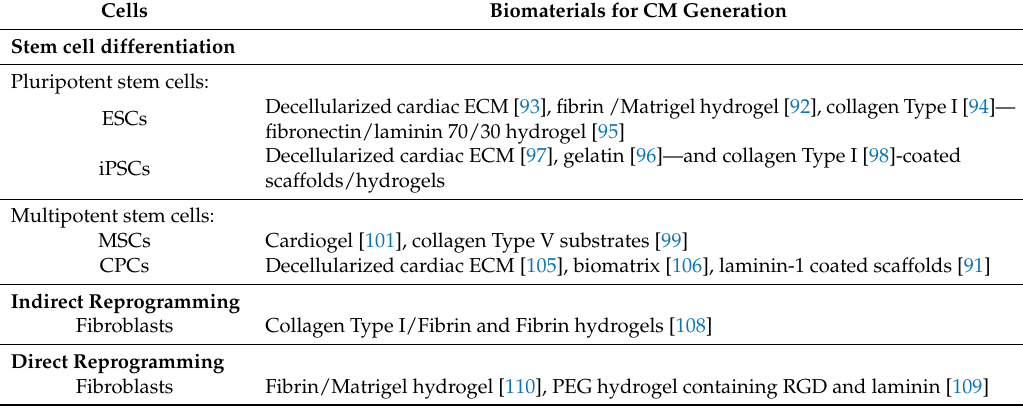
Table 2. Main biomaterial substrates favouring differentiation of stem cells or direct/indirect reprogramming of fibroblasts into